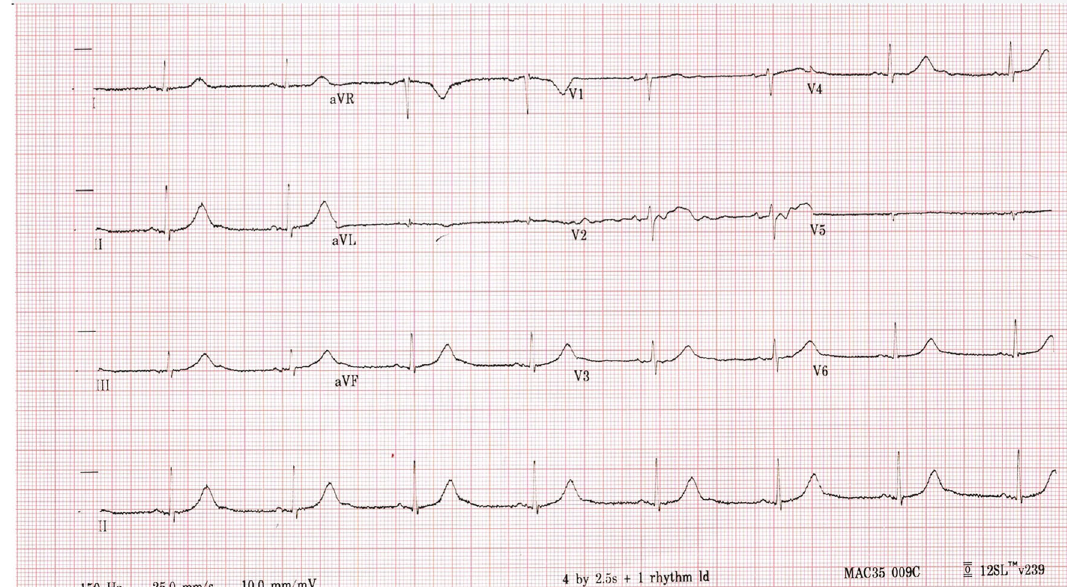
Figure 1: Shows day 1 ECG with a QTc of 495ms.